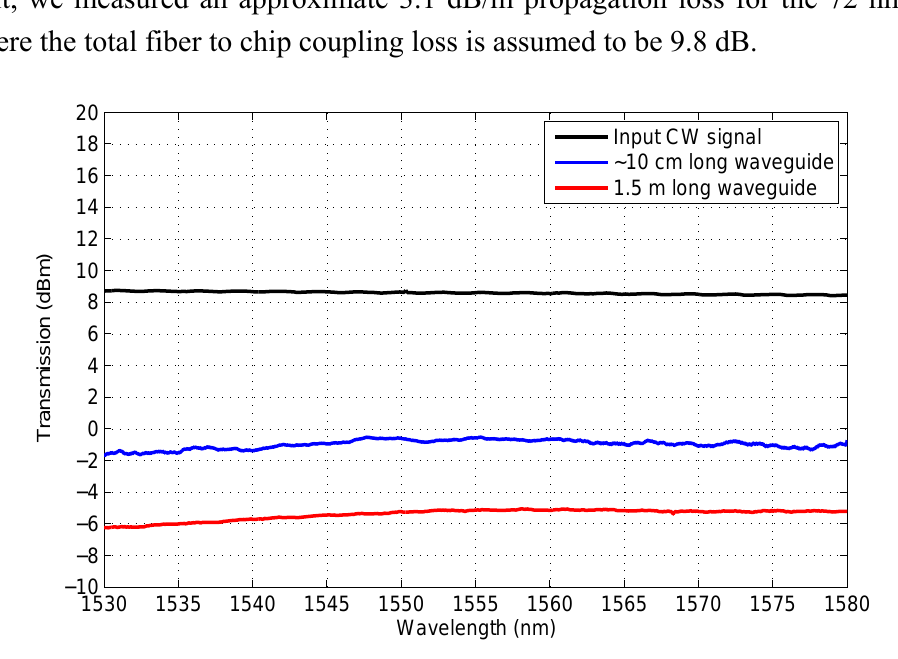
Figure 8. Optical transmission response of the continuous wave (CW) signal from the laser, 10 cm long Si 3 N 4 waveguide and 1.5 m long Si 3 N 4